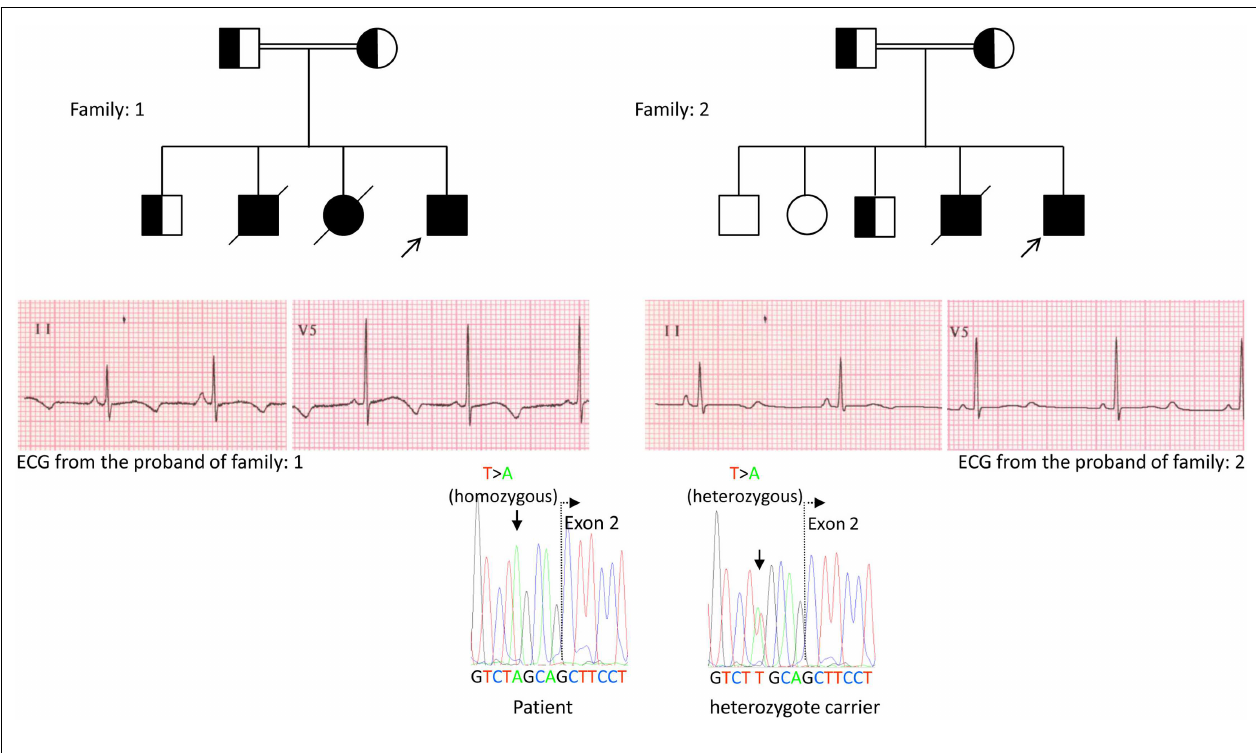
mutation. Affected individuals are shown as filled circles (female) and squares (male). Half filled squares and circles are individuals with heterozygote mutation. Deceased individuals are indicated by slashes, probands are indicated by an arrow and consanguineous marriage is indicated by = Exon − intron boundary is shown by a dotted line with arrow pointing toward